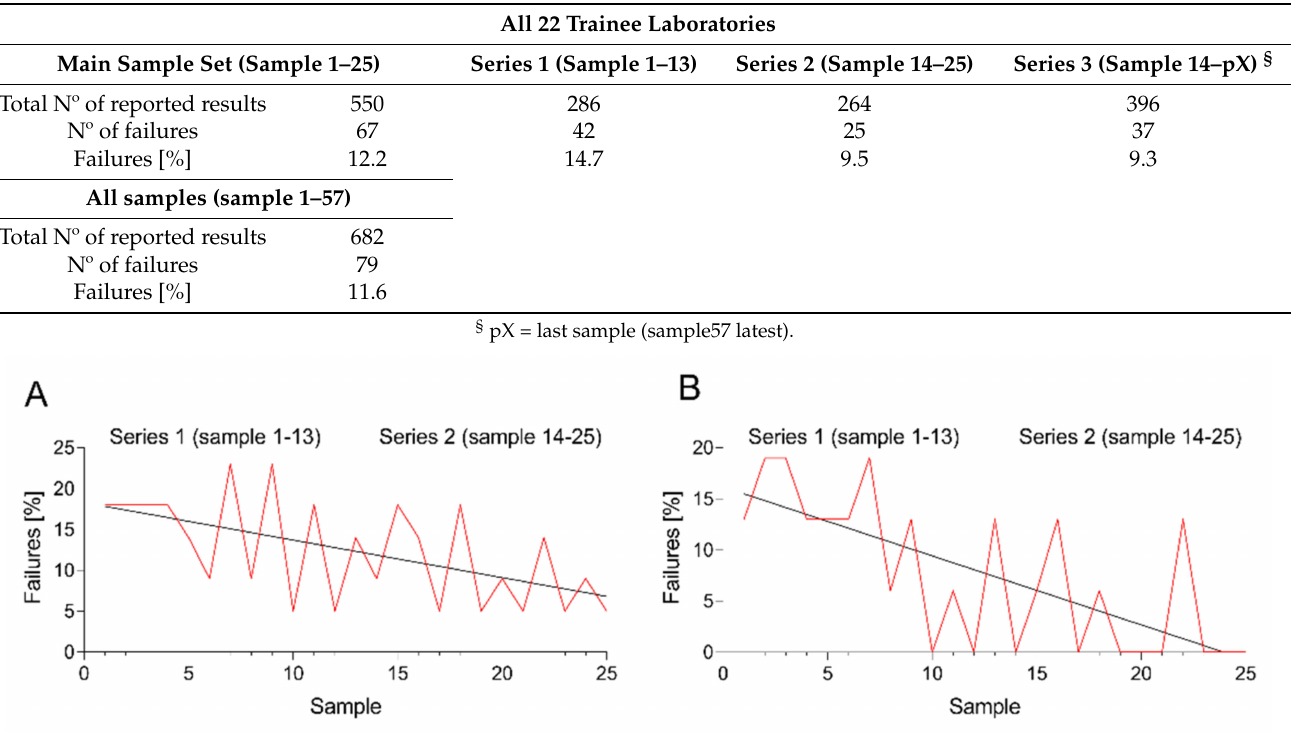
Figure 1. Twinning maturation program. ( A ) Number of failures by all 22 laboratories in the main sample set (samples 1–25) ( B ) Number of failures of the 16 laboratories that finished within a range of a maximum of 31 samples (31 samples = mean number of samples needed for